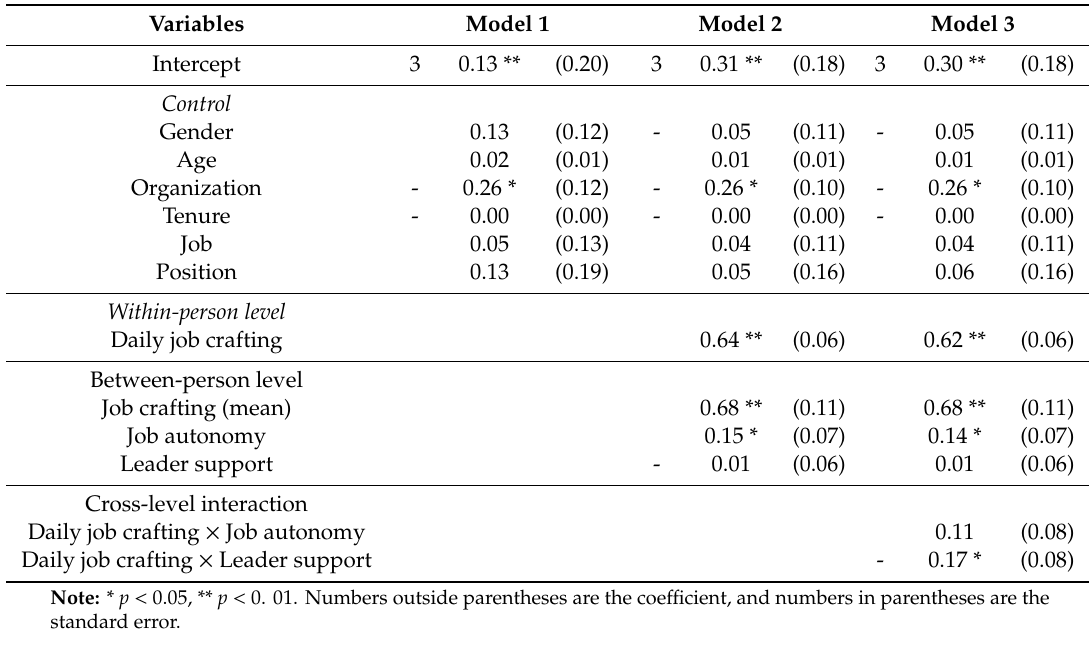
Table 3. HLM Regression: Dependent variable is daily job satisfaction.